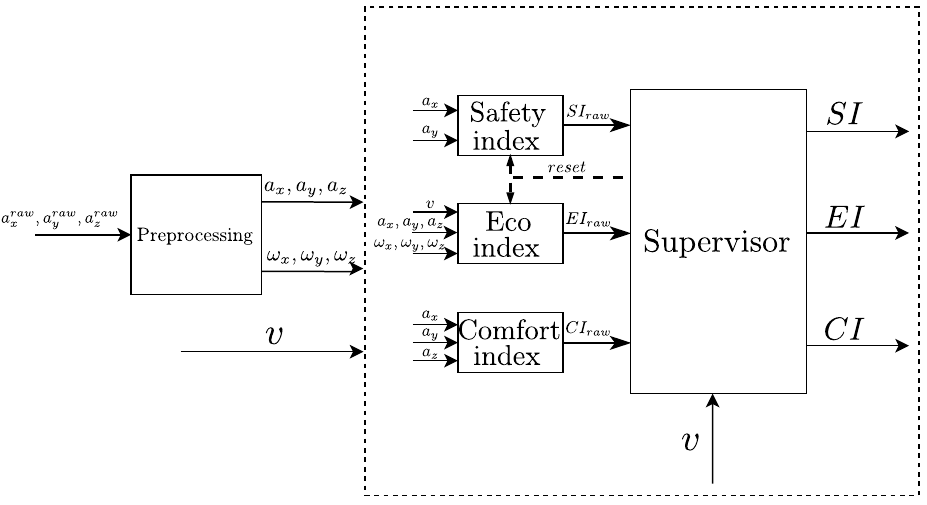
Figure 2. Block scheme of the DS assessment